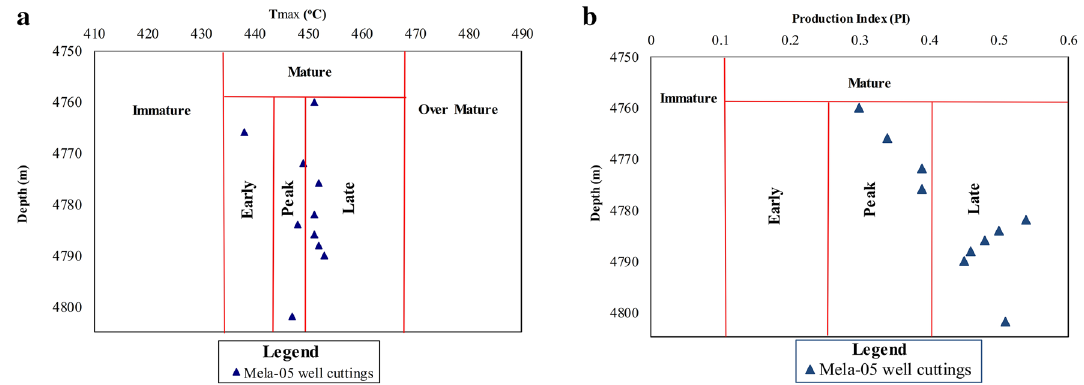
Fig. 6 The organic matter’s thermal maturity within drill cuttings of Chichali Formation using a depth versus T plots (after Peters and Cassa